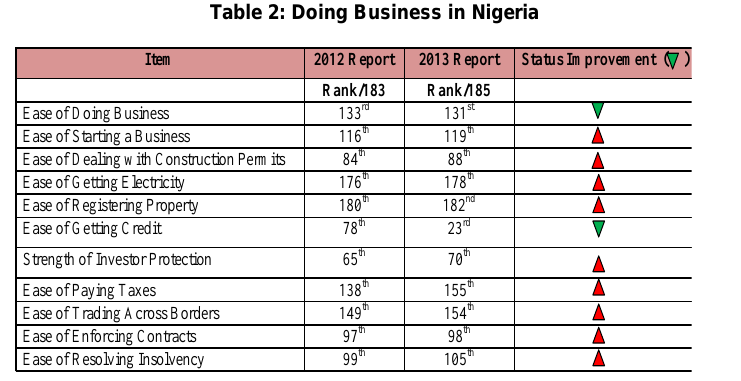
Table 2: Doing Business in